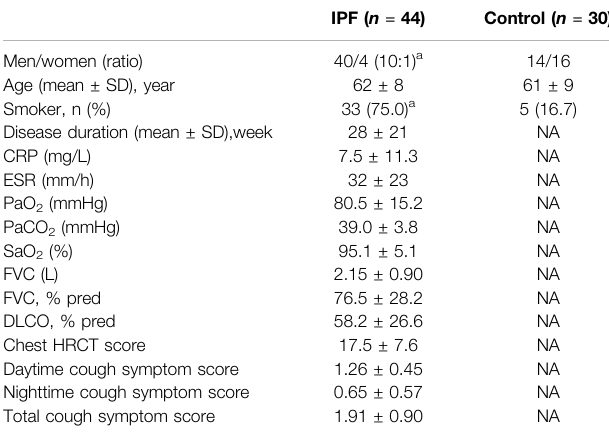
TABLE 3 | Patient general clinical